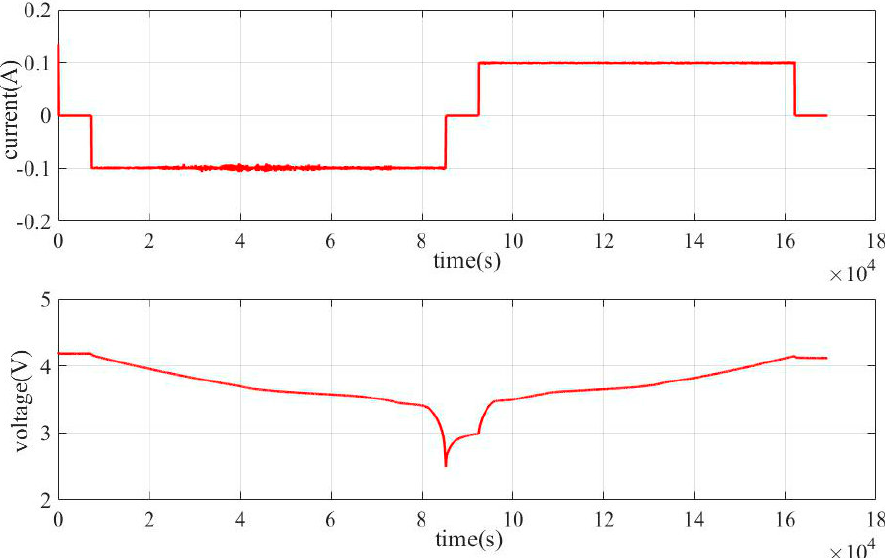
Figure 2. Current and voltage of low-current open-circuit voltage test.